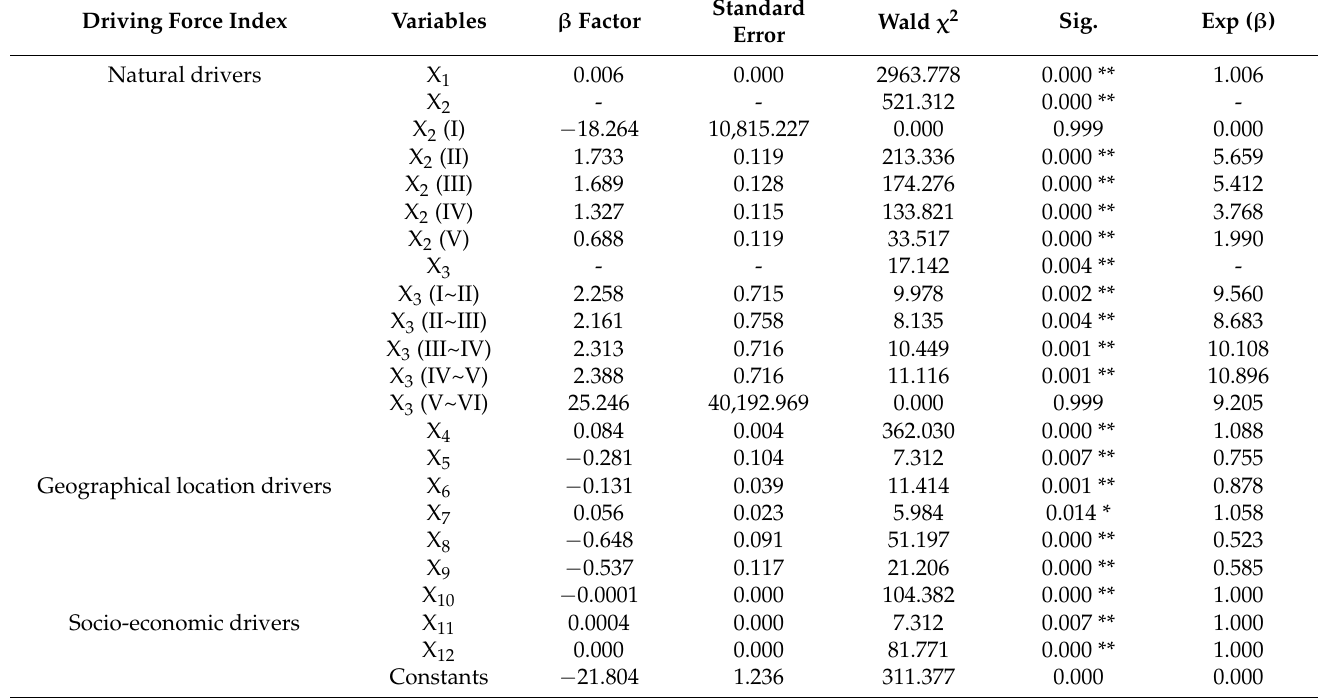
Table 10. Analysis of drivers of forest land change in Anyuan County,